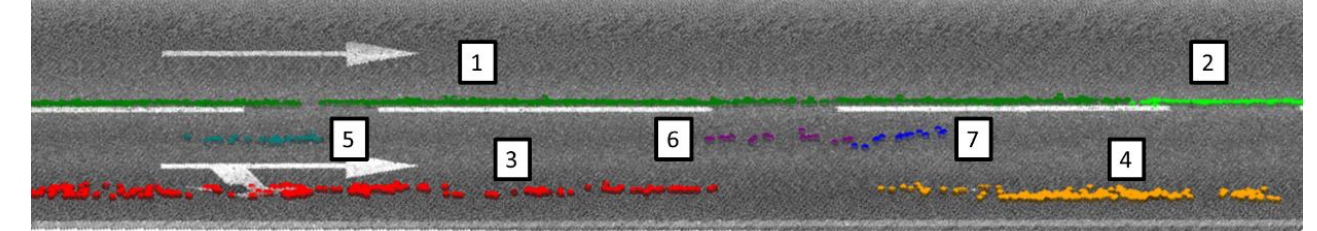
Figure 16. Road spot 3. Crack points detected with the proposed algorithm, grouped in clusters by color.